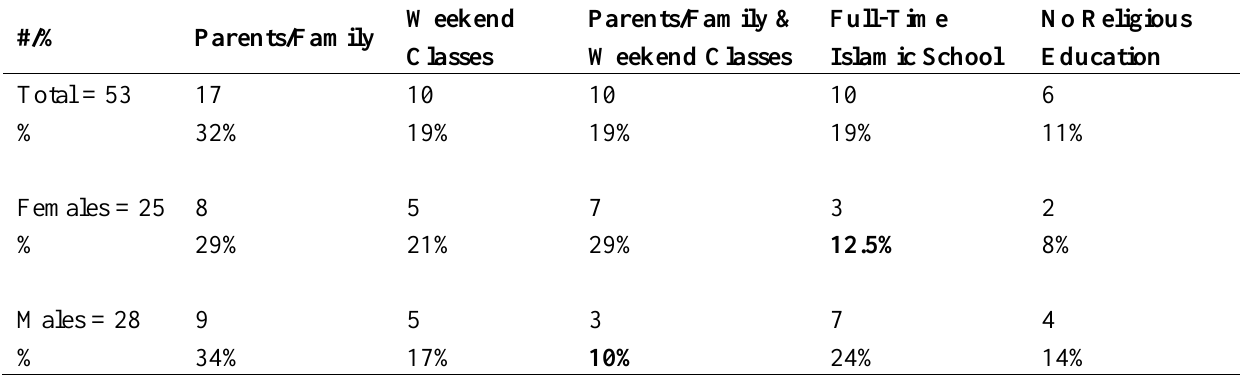
Table 1. Cited Responses to: “How did you know you were a Muslim? How did you learn about your faith when you were